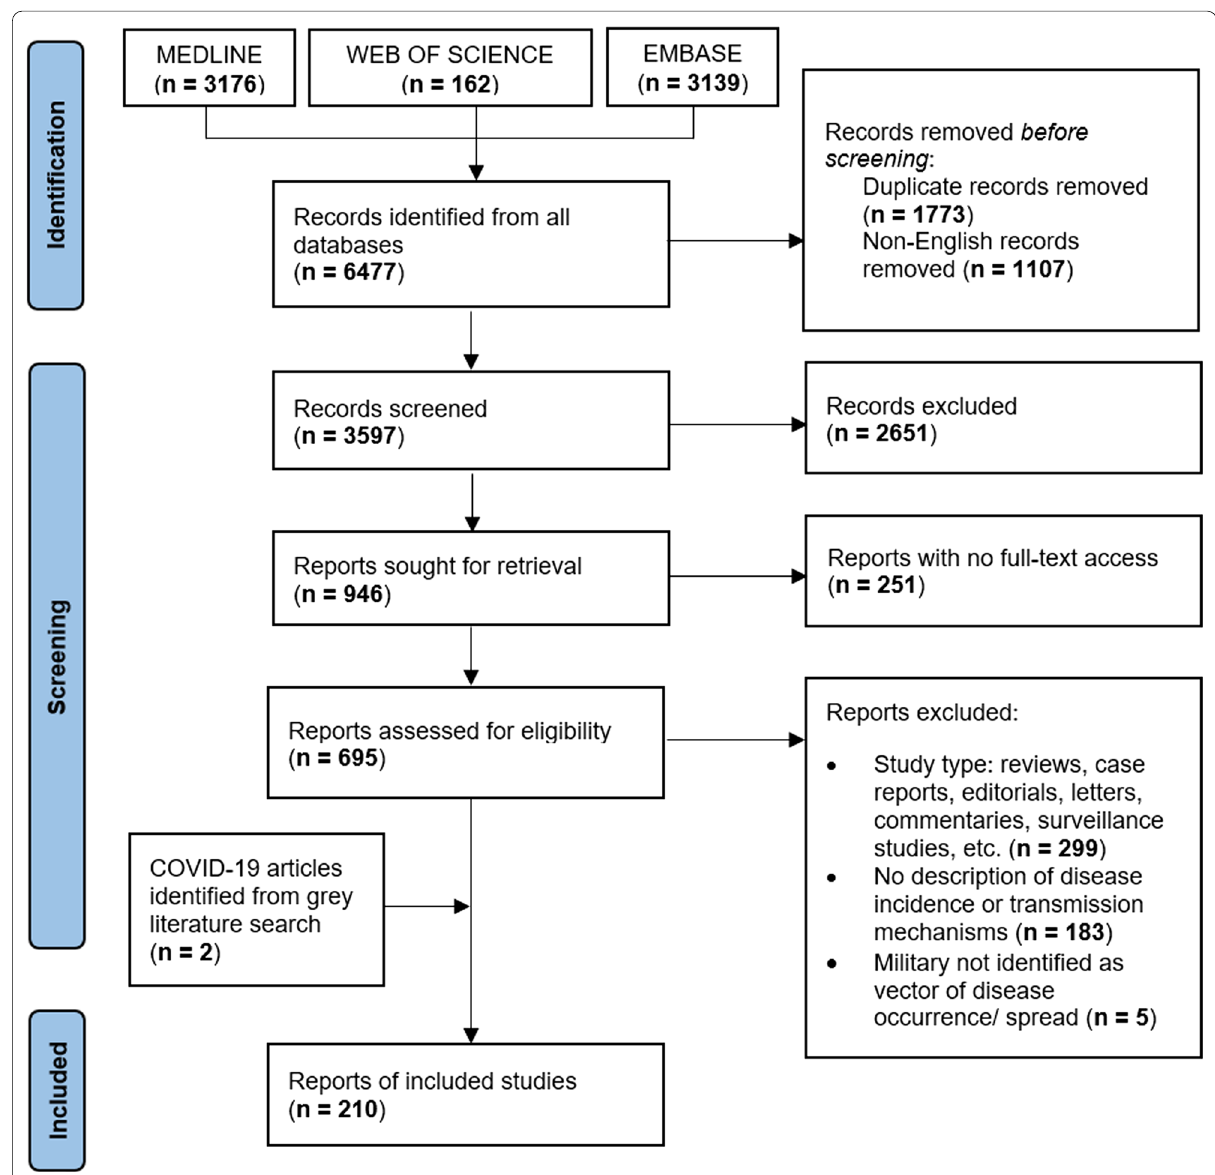
Fig. 1 PRISMA Flow chart for study